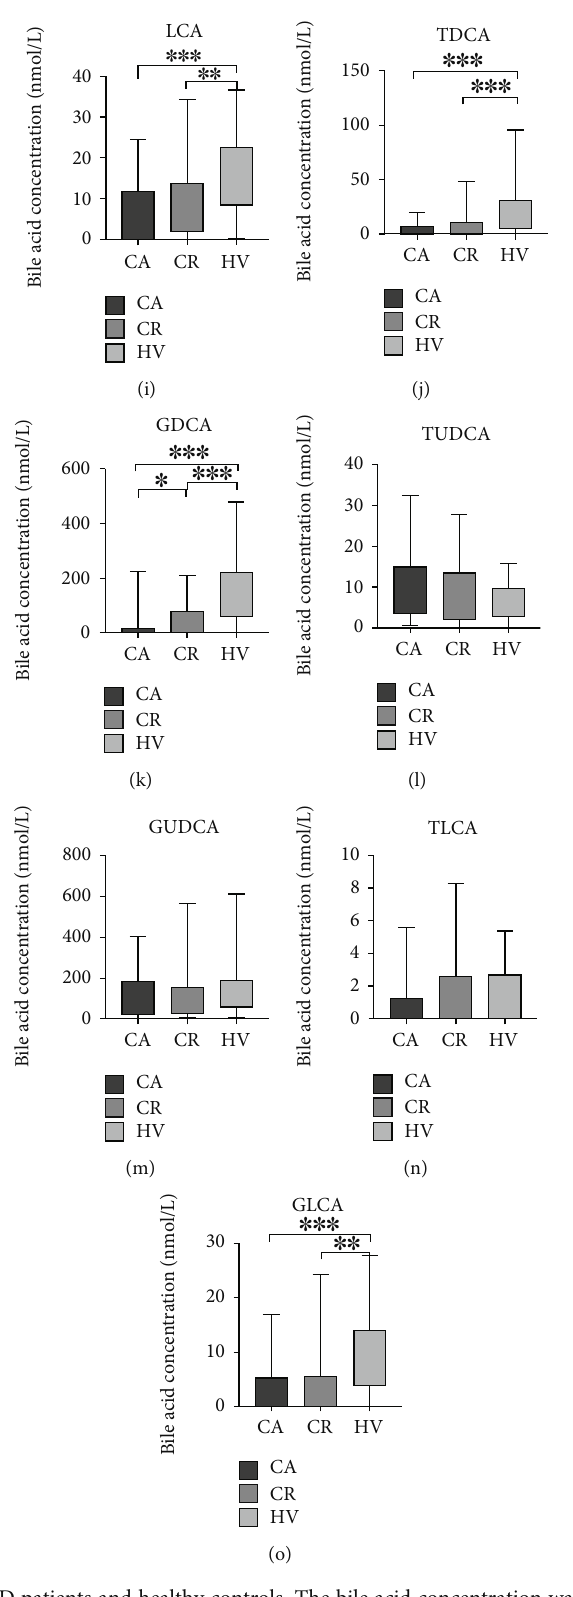
Figure 1: Serum bile acid pro fi le in CD patients and healthy controls. The bile acid concentration was determined in CD active (CA), CD remission (CR), and HV groups. Di ff erences were analyzed with Mann – Whitney U test. * P < 0 : 05 , ** P < 0 : 01 , and *** P < 0 : 001 . CA: cholic acid; CDCA: chenodeoxycholic acid; TCA: taurocholic acid; GCA: glycocholic acid; TCDCA: taurochenodeoxycholic acid; GCDCA: glycochenodeoxycholic acid; DCA: deoxycholic acid; UDCA: ursodeoxycholic acid; LCA: lithocholic acid; TDCA: taurodeoxycholic acid; GDCA: glycodeoxycholic acid; TUDCA: tauroursodeoxycholic acid; GUDCA: glycoursodeoxycholic acid; TLCA: taurolithocholic acid; GLCA; glycolithocholic